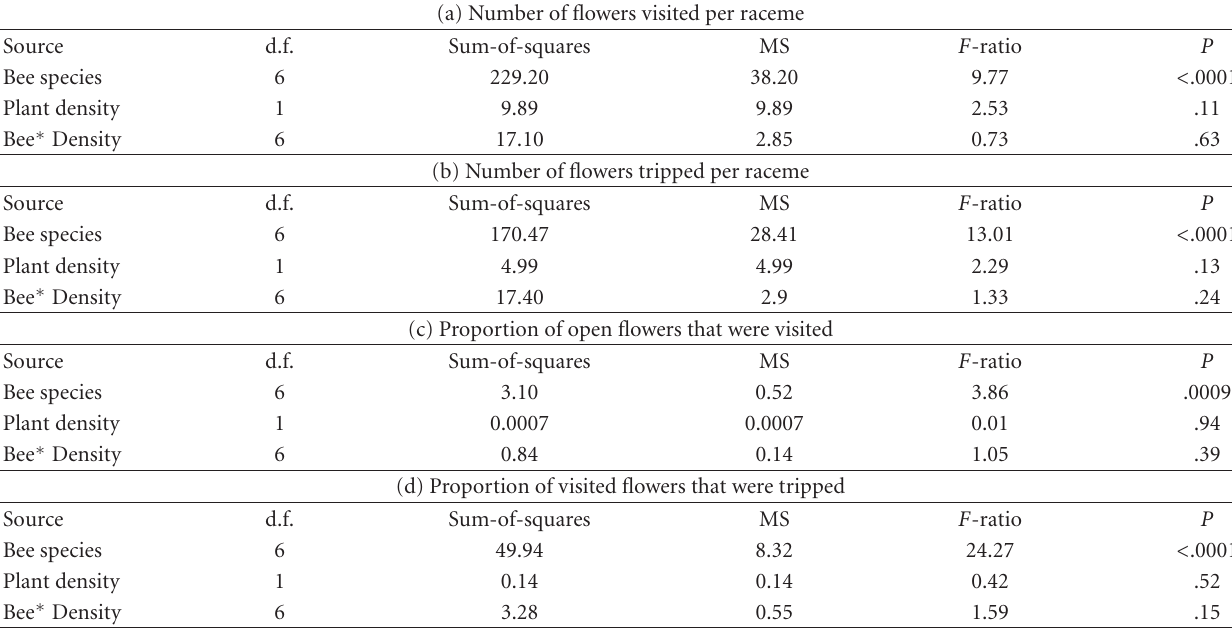
Table 1: Analysis of variance with pollinator species and plant density on (a) the number of flowers visited per raceme; (b) the number of flowers tripped per raceme; (c) the proportion of open flowers that were visited per raceme; (d) the proportion of visited flowers that were tripped per raceme.